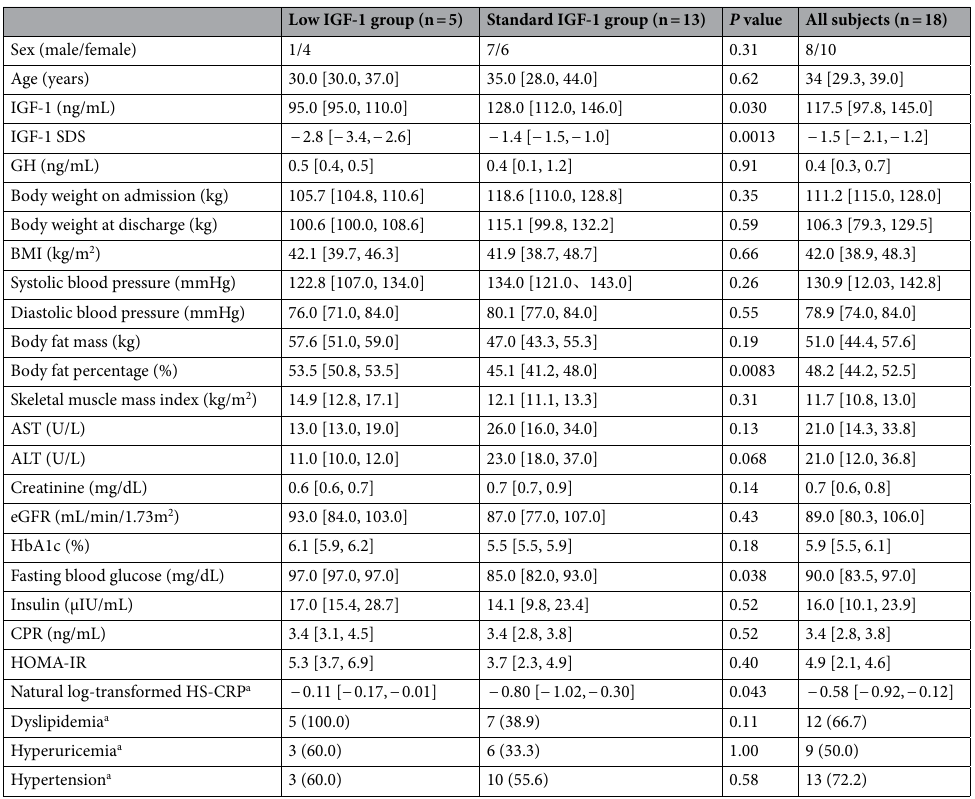
Table 2. Clinical characteristics of the obese subjects without diabetes according to the existence of low serumIGF-1 levels. Because only one subject was conducted abdominal fat measurement in low IGF-1 group, we could not compare the data of visceral of subcutaneous fat area. IGF-1 insulin like growth factor-1, SDS standard deviation scores, GH growth hormone, BMI body mass index, AST aspartate aminotransferase, ALT alanine aminotransferase, eGFR estimated-glomerular filtration rate, HbA1c hemoglobin A1c, CPR connecting-peptide immunoreactivity, HOMA -IR homeostatic model assessment for insulin resistance, HS - CRP high-sensitivity C-reactive protein. a Values are the number